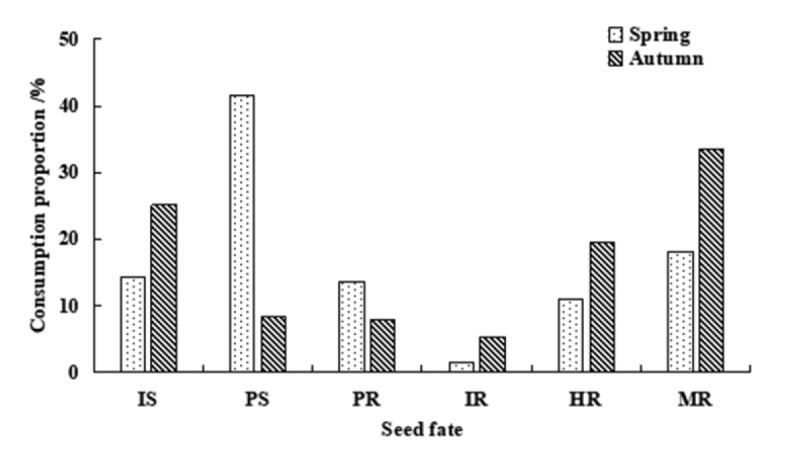
Statistics of the fate of seeds in the spring and autumn in temperate forests of Northeast China. Abbreviations: IS–Intact in situ, PS–Predation in situ, PR–Predation after removal, IR–Intact after removal, HR–Hoarded after removal, MR–Missing after removal.